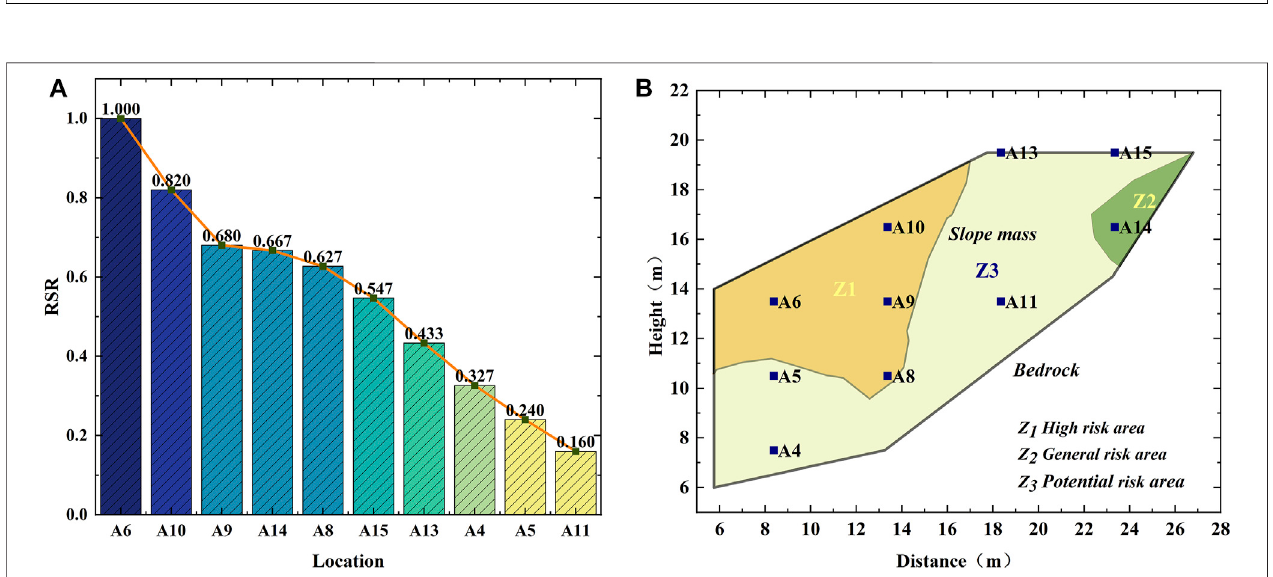
FIGURE 9 | Comprehensive evaluation results: (A) RSR ranking histogram (B) Slope risk zoning map.